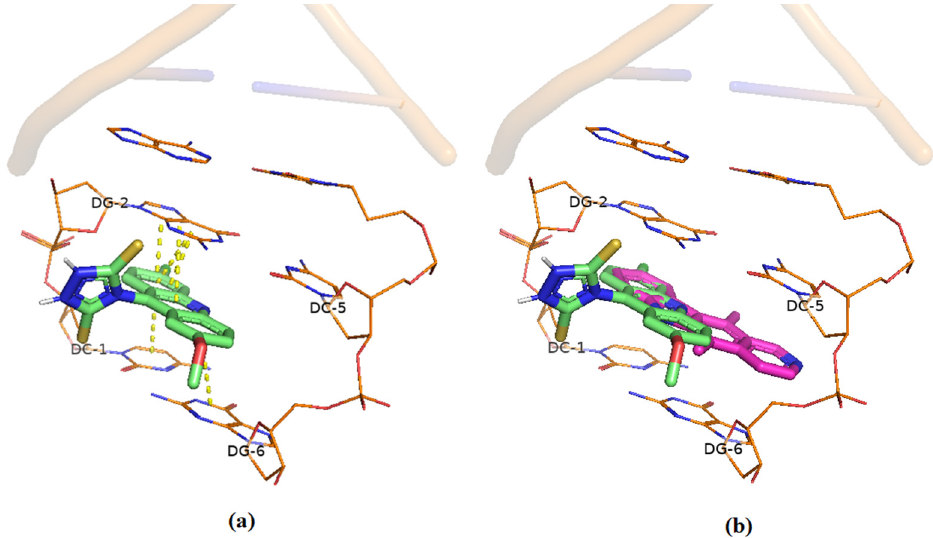
Figure 6. Proposed fit for ACW-02 in DNA (PDB ID: 1Z3F). ( a ) on the left, the proposed molecular fit of ACW-02 in DNA; hydrophobic interactions with DNA bases are shown in yellow dashed lines. ( b ) overlap of ellipticin fitting (magenta) with the ACW-02 (green).